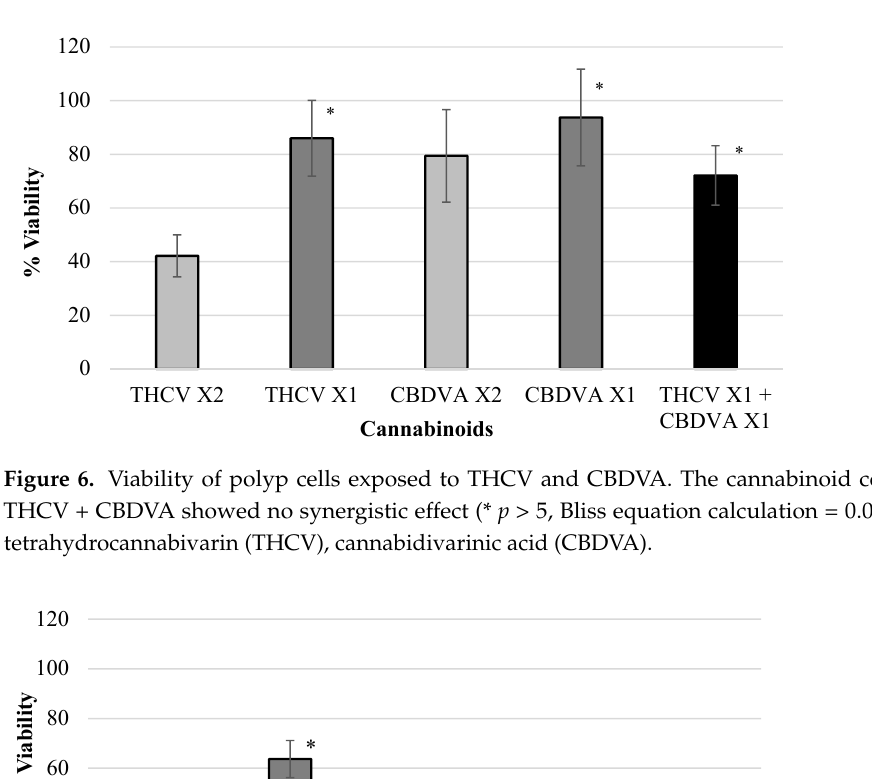
Figure 5. Viability of polyp cells exposed to THCV and CBGA. Combinations between THCV (at X2 concentration—40/48 µM or X1 concentration—20/24 µM) and CBGA (at X2 concentration—51.2 µM or X1 concentration—25.6 µM) significantly inhibited the viability of polyp-derived cells. The can- nabinoid combination THCV + CBGA (* p < 0.0025, Bliss equation calculation = 0.45) presented a